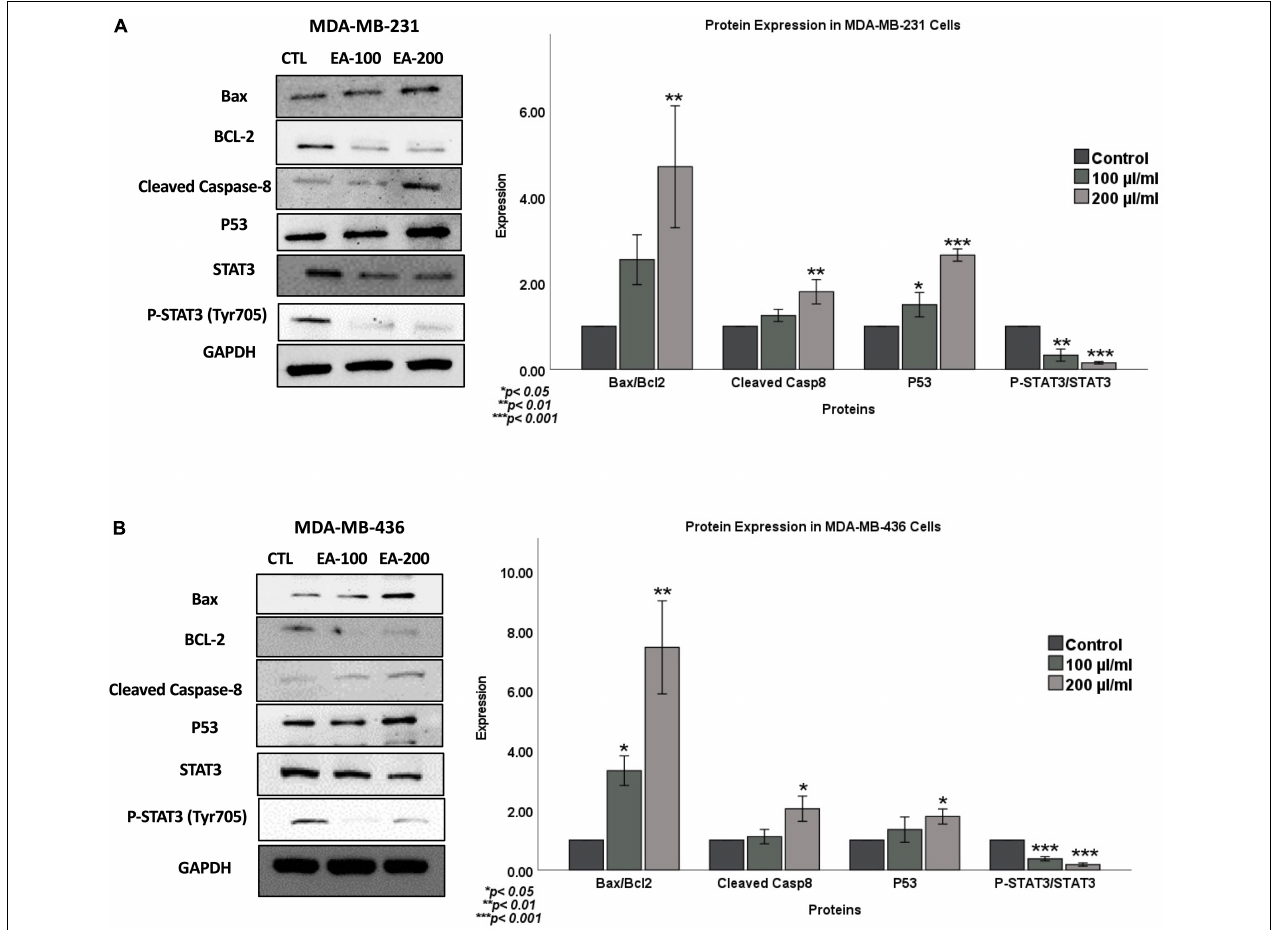
FIGURE 6 | Outcome of EA extract on the expression patterns of Bax, BCL-2, Caspase-8, P53 and STAT3 in (A) MDA-MB-231 and (B) MDA-MB-436 cell lines. We note that EA extract induces an overexpression of the pro-apoptotic markers (Bax and Caspase-8) in comparison with their control, while anti-apoptotic marker Bcl-2 is inhibited. Furthermore, EA plant extract enhances the expression of p53 while inhibits phosphorylation of STAT3. GAPDH served as a control in this assay. Cells were treated with 100 and 200 µ l/ml of EA extract for 48 h as explained in the materials and methods section. Values were corrected for the expression of the housekeeping protein GAPDH and presented as fold change of control. Data were analyzed using One-way ANOVA followed by Dunnett’s post hoc test. *P-value < 0.05 was considered for statistical significance. *p < 0.05 , **p < 0.01, and ***p < 0.001. Data are presented as a percentage of treatment relative to the control (Mean ± SEM; n =